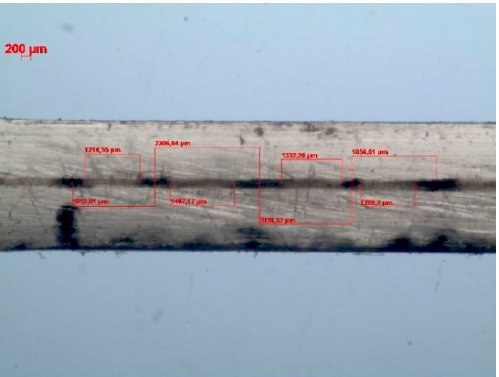
Figure 6. Typical optical micrograph of a fragmented flax yarn in an epoxy matrix: measurement of the yarn fragment length l .